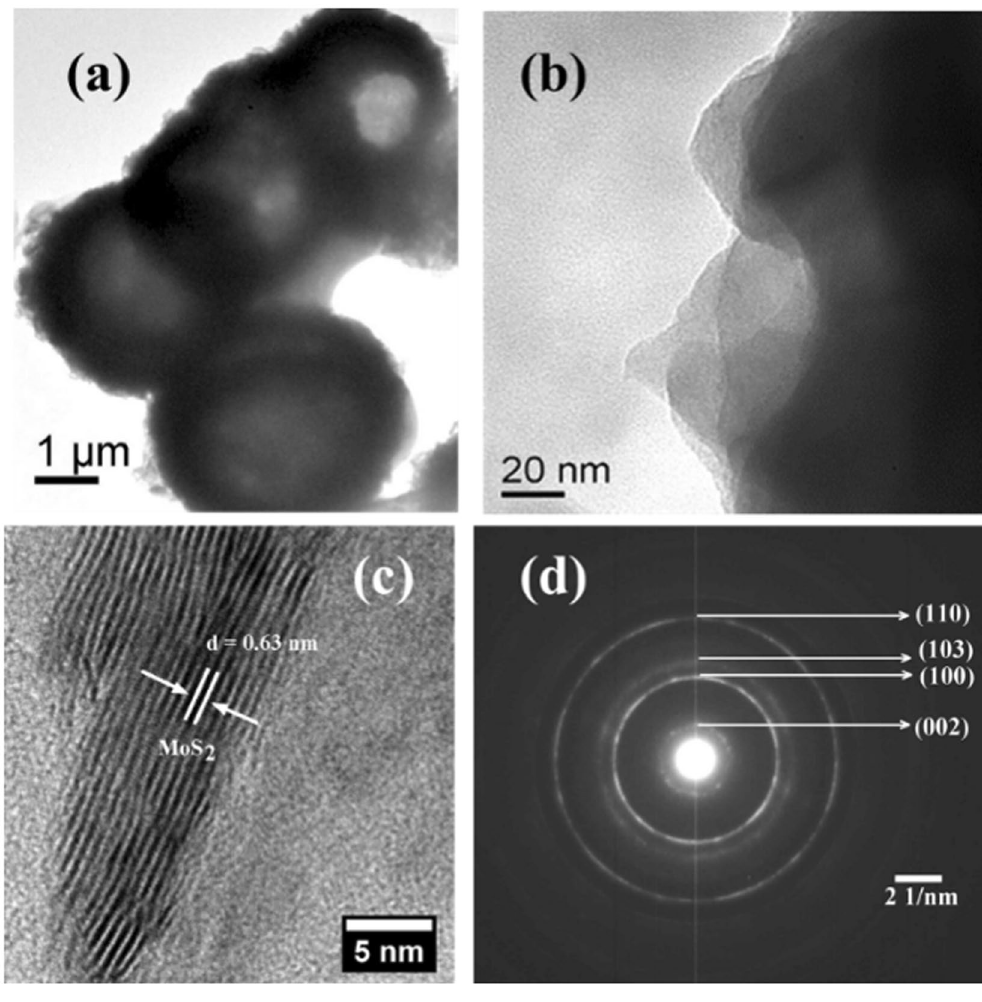
Figure 3. HRTEM image of MoS 2